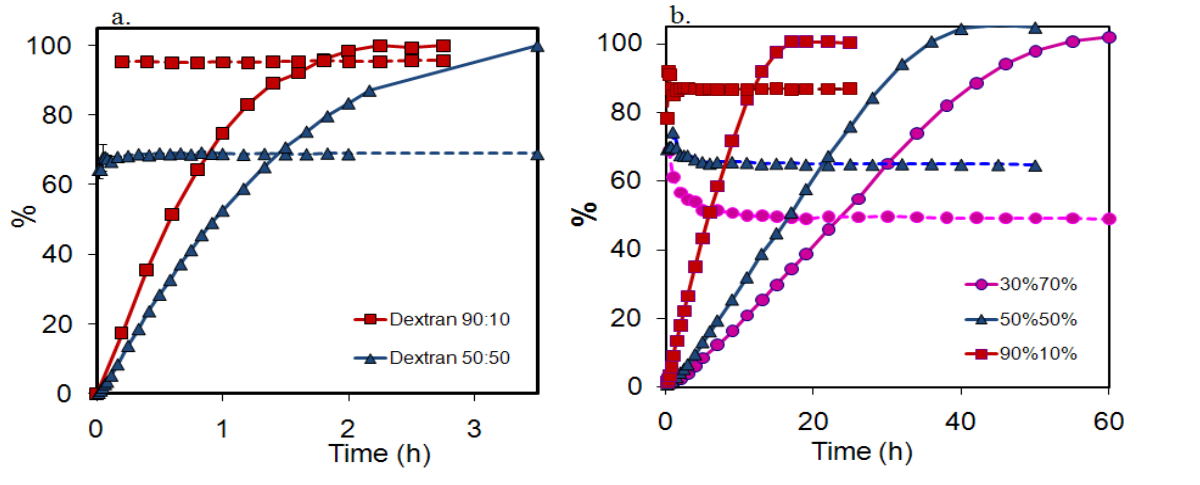
Figure 3. The released fraction low molecular weight polymer (dotted lines) together with the polymer release profiles (full line) for the mixed dextran compositions as indicated in the figure legend (a) and the mixed HPMC 60SH compositions as indicated in the figure legend (b). The symbols denote the calculated average from two tablets and the error bars indicates the positions of the individual measurements.